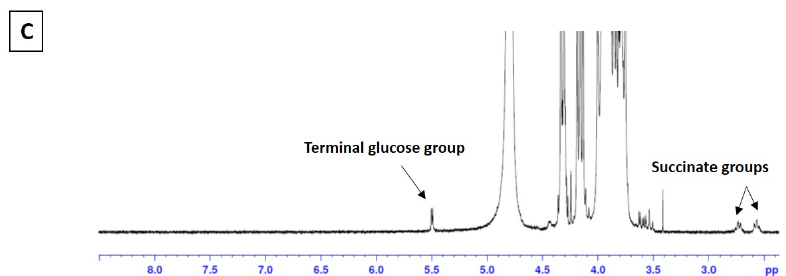
Figure 2. Characterization of MPI-Doxorubicin ( A ) FTIR MPI and doxorubicin; ( B ) FTIR succinate-modified inulin and MPI-doxorubicin conjugate, ( C ) 1 H NMR spectra of succinic anhydride-functionalized MPI particles.